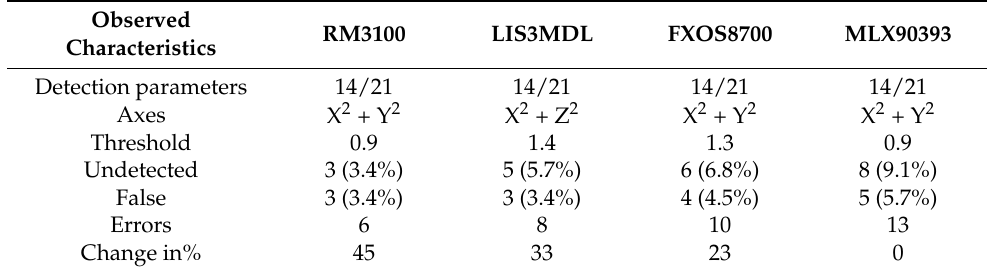
Table 8. Detection parameters and results for measurement 1.